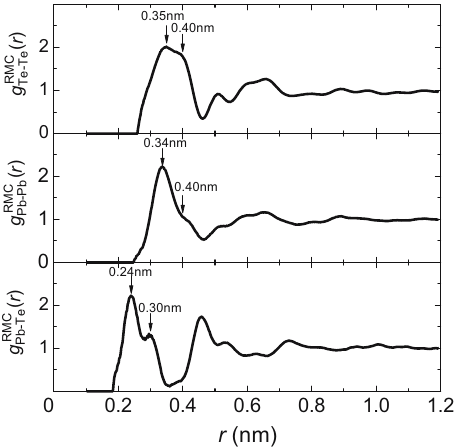
Figure 4: Reproduction of ( ) S Q ij RMC ’ s by using Reverse Monte Carlo